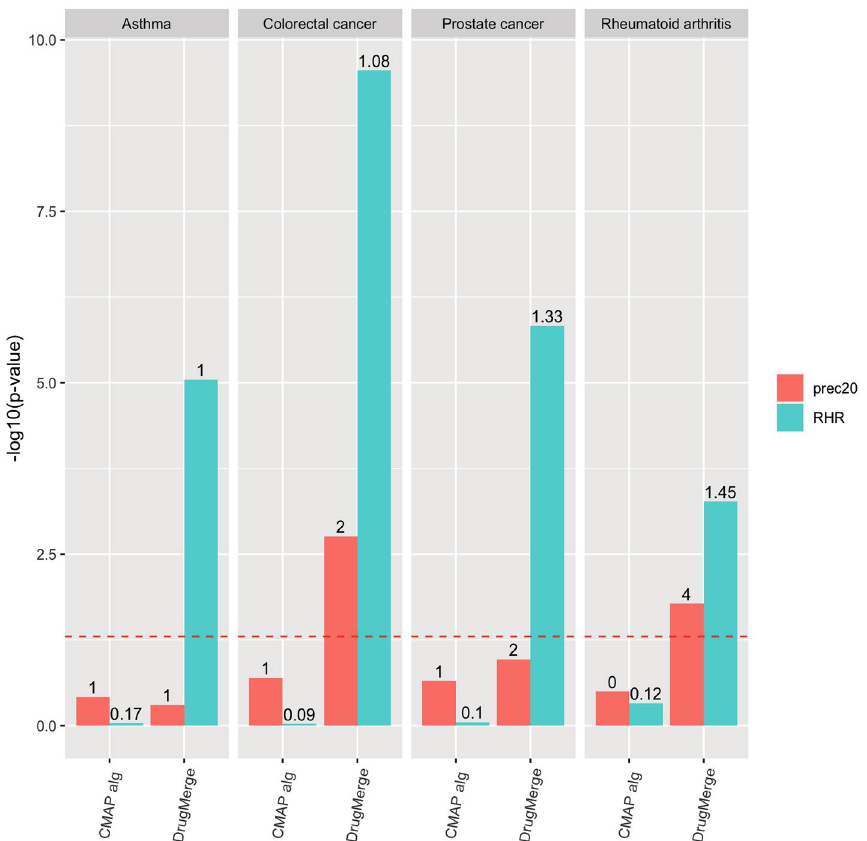
Figure 4. Comparison of performance of DrugMerge and the CMAP algorithm across the four benchmark diseases. For Colorectal Cancer and Prostate Cancer both methods use CMAP data. For Asthma and Rheumatoid Artrithis DrugMerge uses GEO data. The bars represent the − log 10 ( p value ) with respect to the precision@20 (red), and the RHR (light blu). The numbers on the top of the bars show the absolute values of precision@20 or RHR. The dotted red line represents the limit of significance ( − log 10 ( 0.05 ) ). All the bars above the dotted line show a significant p-value. The plot has been generated by the ggplot2 81 R